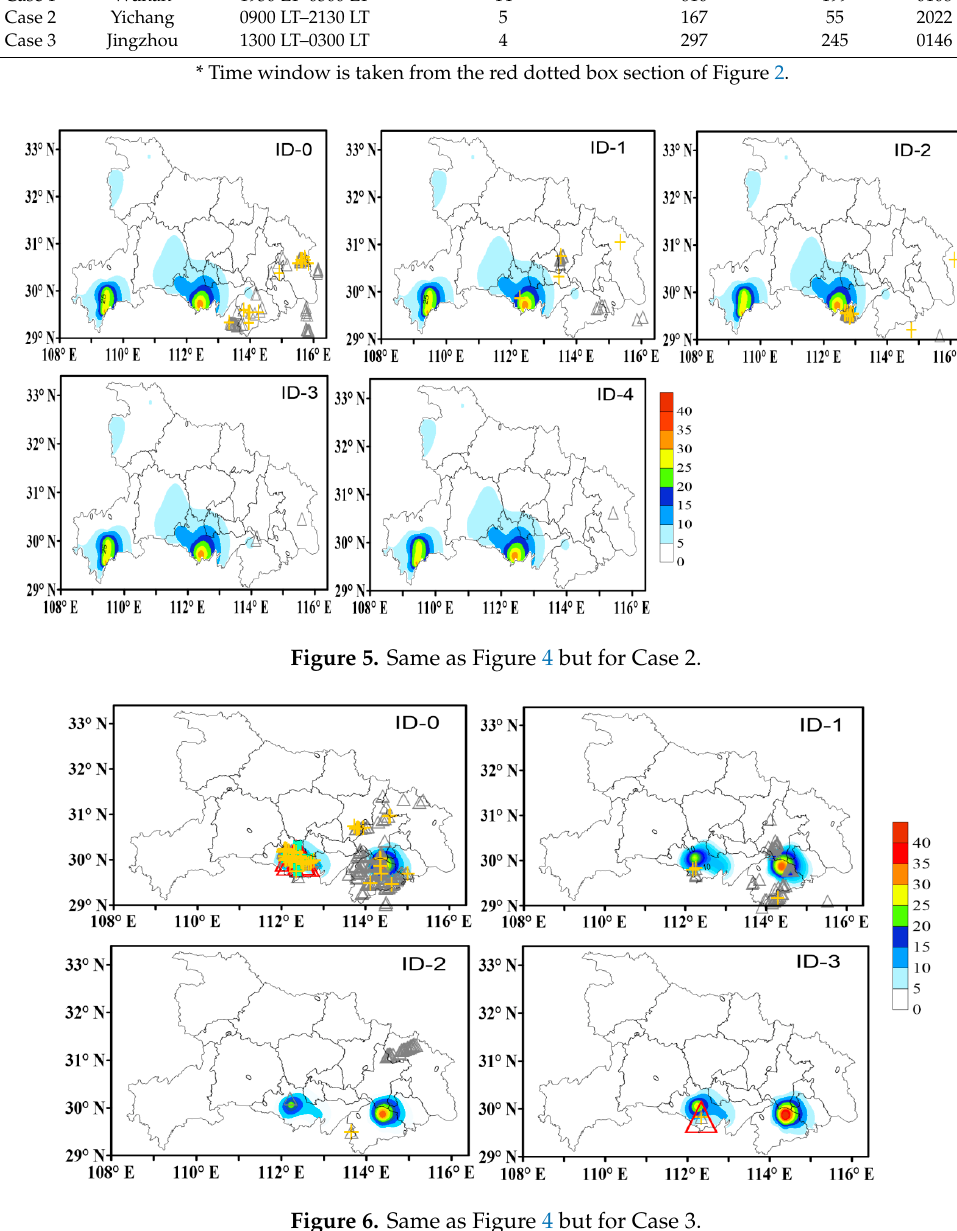
Figure 6. Same as Figure 4 but for Case 3.